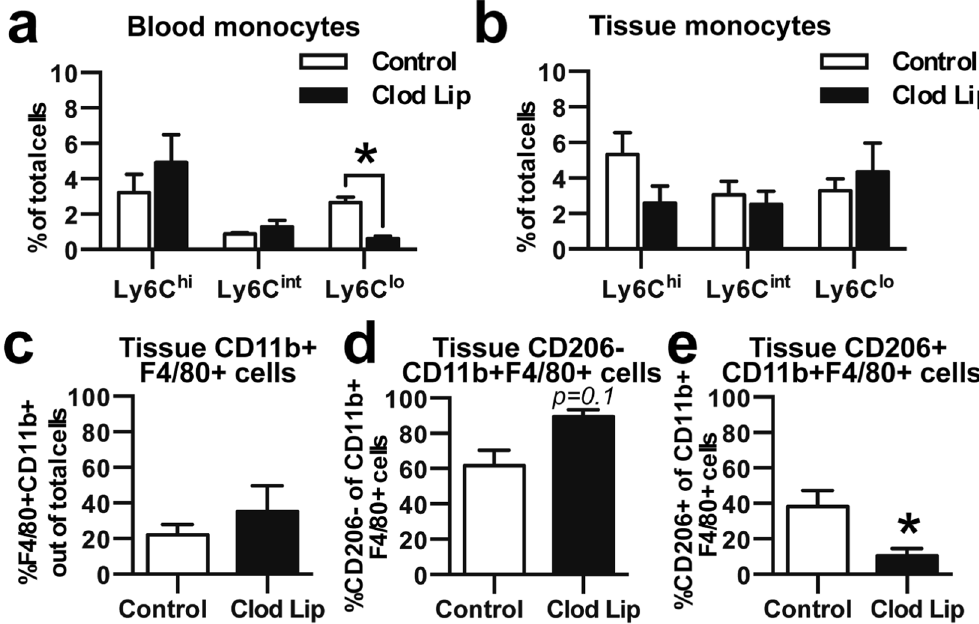
Figure 3. Loss of Ly6C lo monocytes impairs generation of CD206 + alternatively activated macrophages. ( a ) Clodronate liposome (Clod Lip) administration two days before DWC surgery reduced the frequency in blood of Ly6C lo monocytes, but not Ly6C hi or Ly6C int monocytes. ( b ) Frequency of Ly6C lo , Ly6C int , Ly6C hi monocytes after Clod Lip administration in digested dorsal tissue 3 days post-injury. ( c ) Total CD11b + F4/80 + macrophages, ( d ) CD206 − macrophages, and ( e ) CD206 + alternatively activated macrophages 3 days post- injury. Data presented as mean ± S.E.M. Statistical analyses were performed using two-tailed t-tests * p < 0.05, n = 4–8 animals per